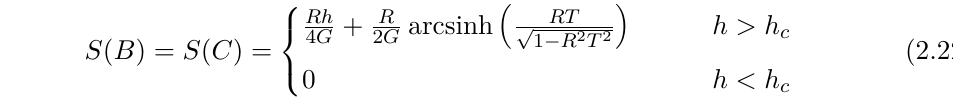
Figure 11 . τ = 0 , ± π slice of the thermal AdS 3 geometry cut off by ETW branes. The “usual” candidate RT surface γ is depicted in yellow. Such surface is always subdominant, because the 2 empty set γ , which has zero area, is always 1